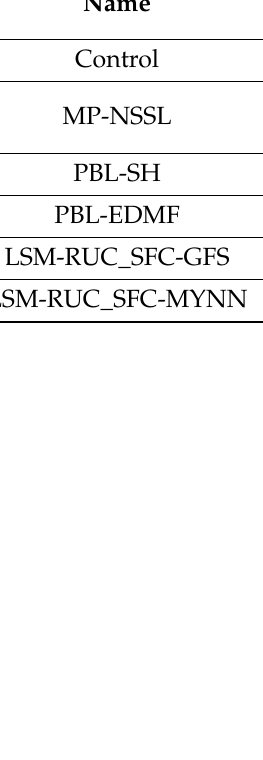
Table 2. Description of configurations for the 2020 HWT dataset used in this